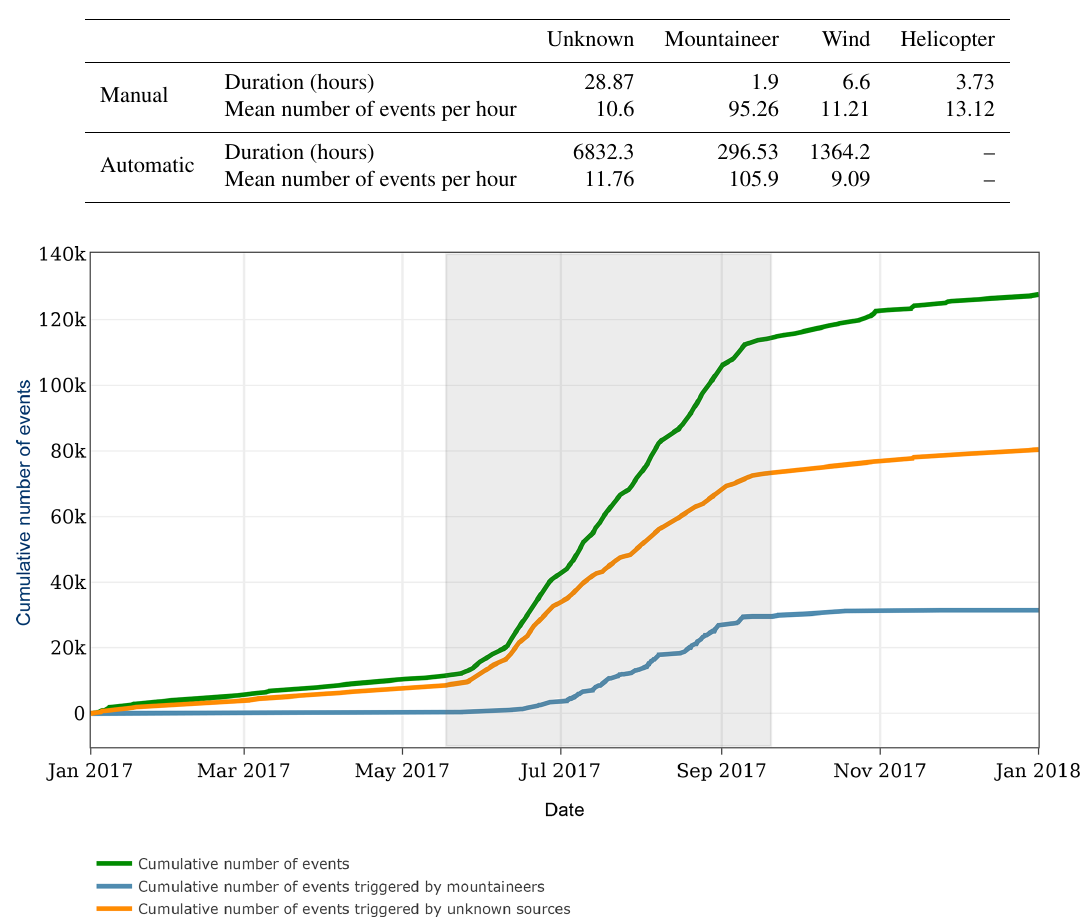
Figure 12. Illustration of the cumulative number of events triggered by the STA/LTA event detector for all events, for events triggered by mountaineers and for events triggered by unknown sources. The results presented in this paper were used to annotate the events. The time period during which the rock temperature in 1m depth is above 0 ◦ C is shaded in